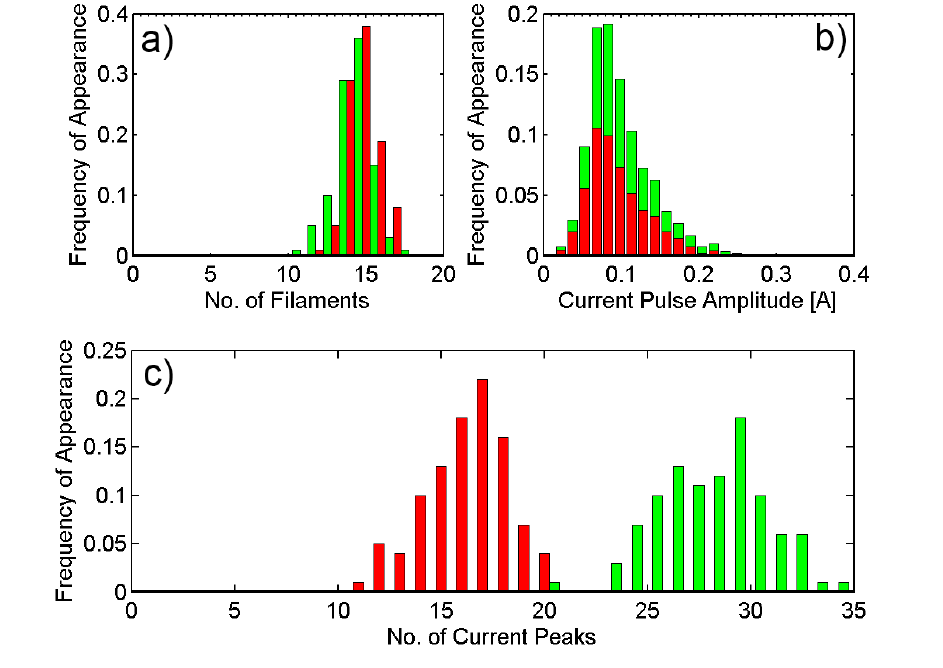
Figure 7 : Histograms of: a) number of filaments, b) distribution of microdischarges current and c) number of microdischarges. Red bars correspond to positive half-period of discharge; green bars correspond to whole period of the discharge. Discharge conditions were as follows: DCSBD generated using sine-wave HV of the amplitude of 16 kV, electrode gap width set to 0.6 mm.